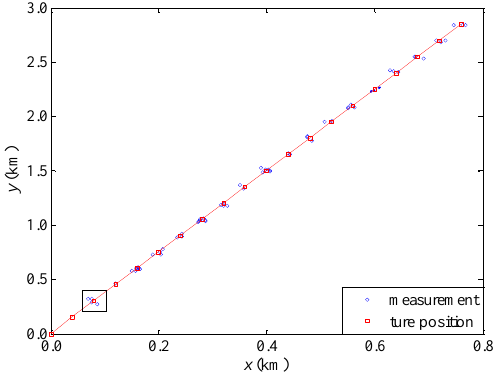
Figure 1. Target tracking in a cluttered environment.